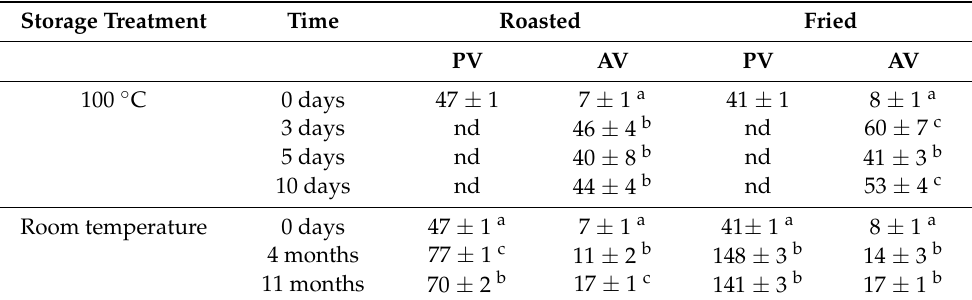
Table 3. Changes in PV (meq O 2 kg − 1 seed oil) and AV (absorbance units at 350 nm g − 1 seed oil) values for roasted and fried sunflower seed oils as a function of oxidation time at 100 ◦ C and storage at room